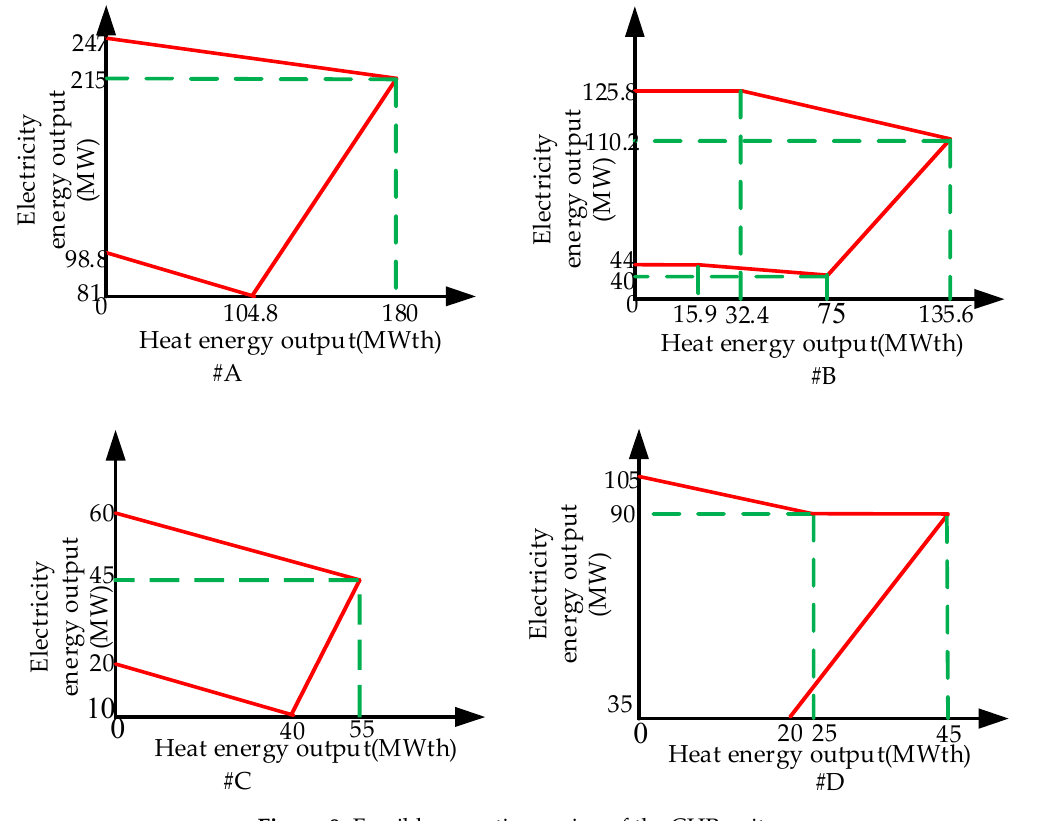
Figure 9. Feasible operation region of the CHP unit. Table 5. Parameters of renewable energy resources.